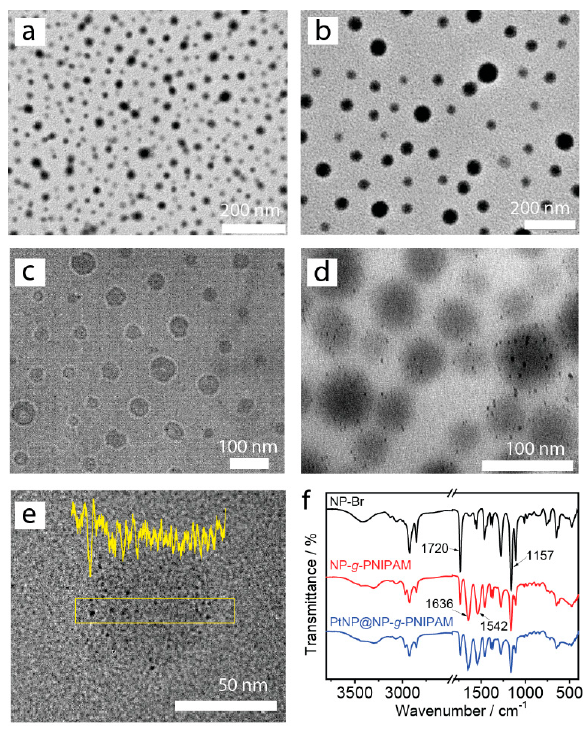
Figure 1. TEM images of NP-Br ( a ), NP-PNIPAM ( b ), PtNP@NP- g -PNIPAM ( d , e ), cryo-TEM image of